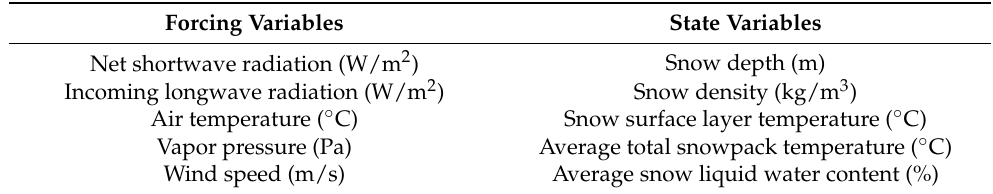
Table A1. Required forcing variables and modeled state variables for SNOBAL (after Marks et al.